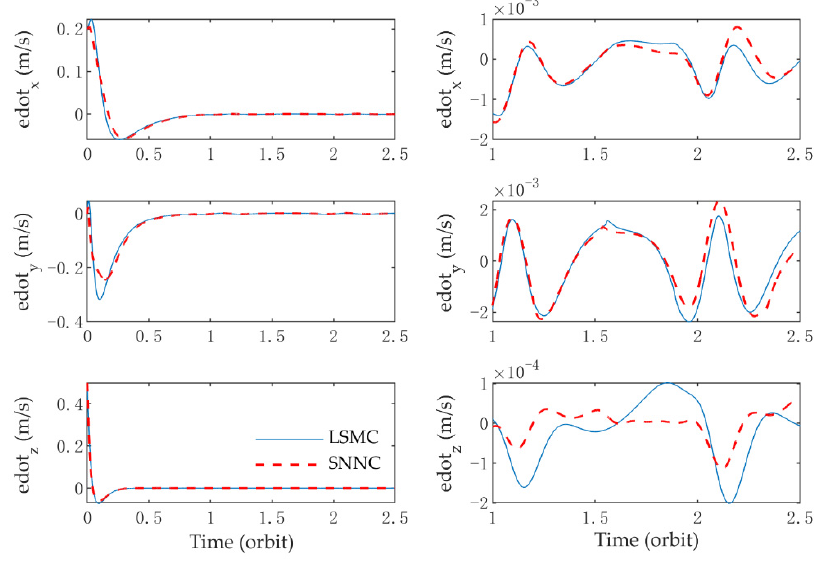
Figure 3. Time histories of relative velocity errors for the case without radial control.